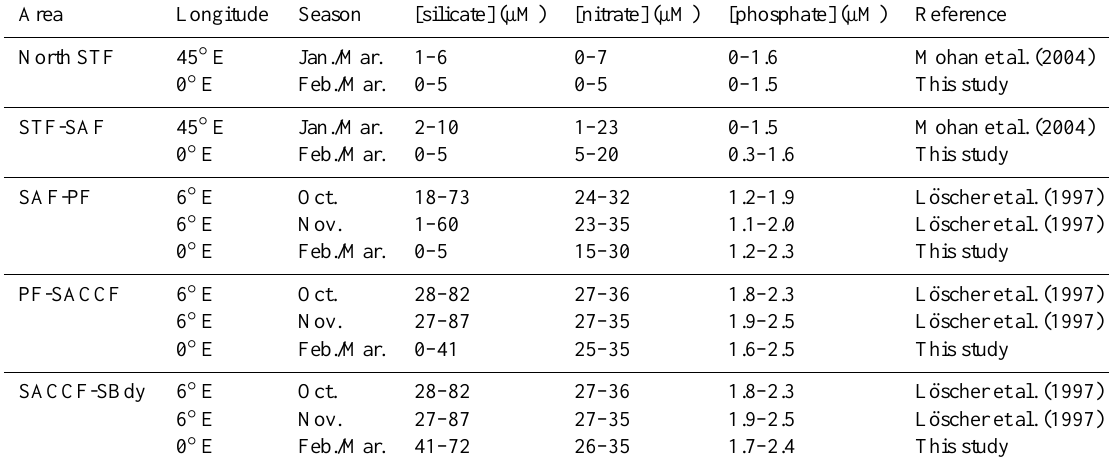
Area Longitude Season [silicate] (µM) [nitrate] (µM) [phosphate] (µM)